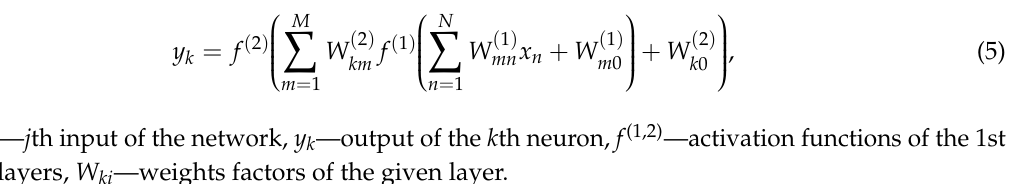
Figure 4. Structure of the self-organizing Kohonen map—SOM.